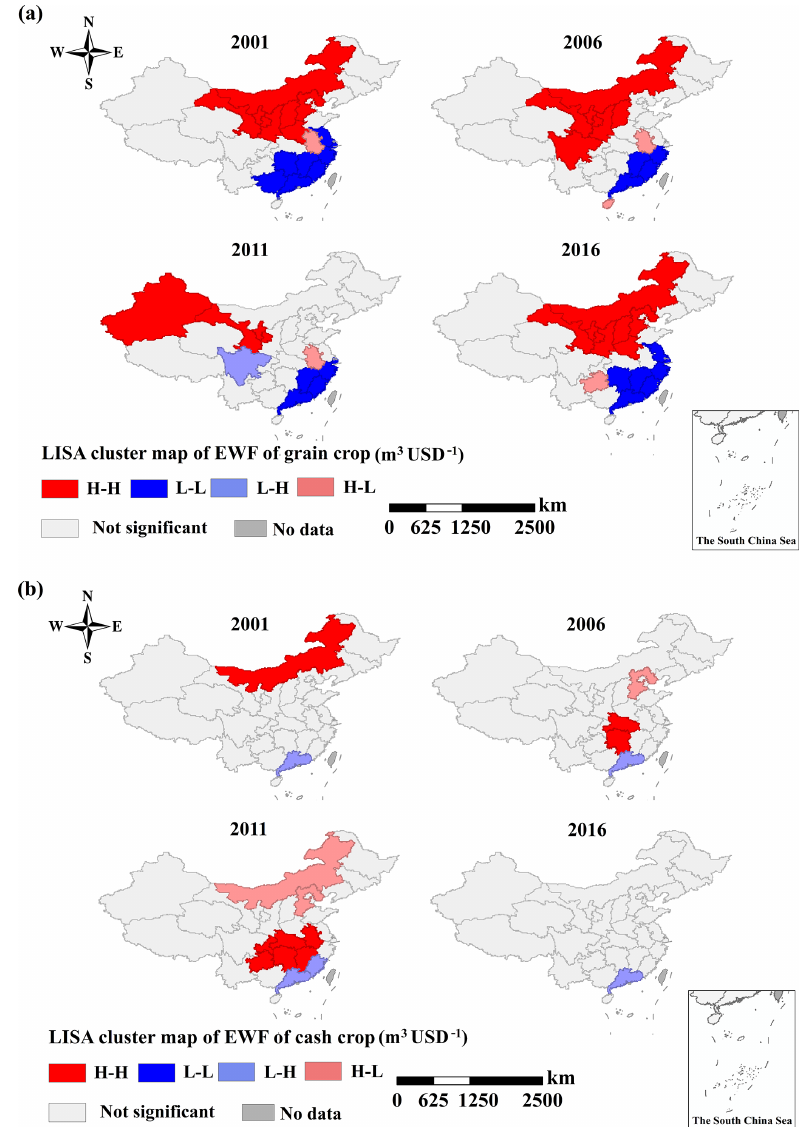
Figure 7. The LISA cluster maps of economic value-based water footprint (EWF) of (a) grain and (b) cash